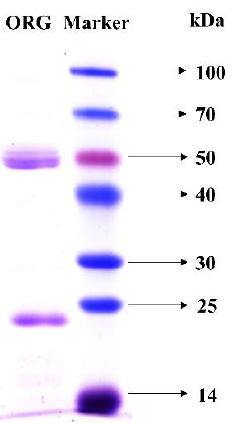
Figure 2. The ORG as visualized by SDS-PAGE. Protein concentrations were approximately 1 mg/mL. ORG represents purified Oudemansiella radicata α -galactosidase. Table 2. Sequence alignment of ORG with other α -galactosidases.